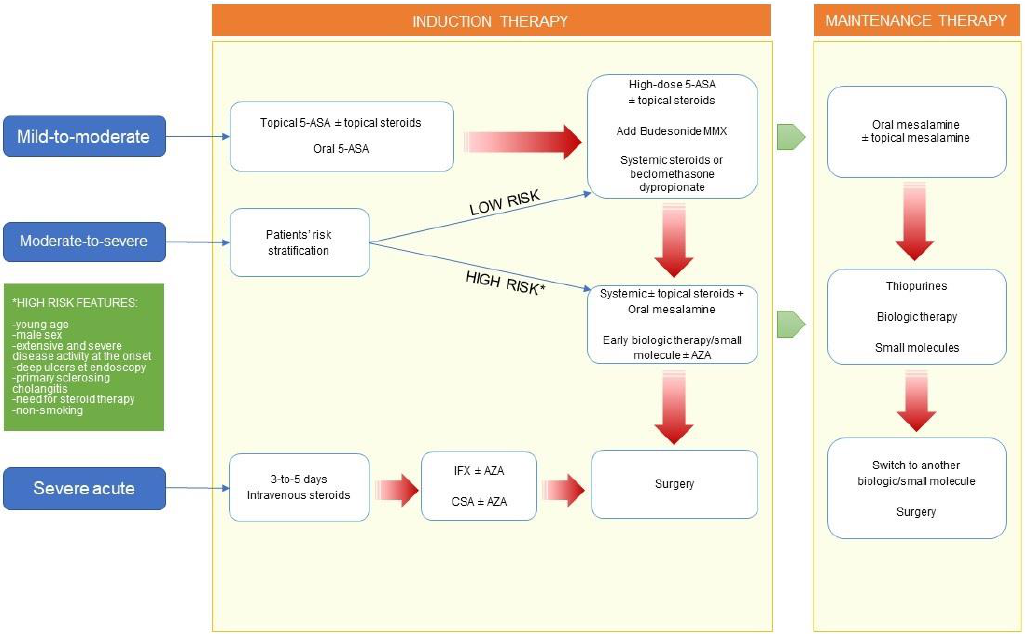
Figure 1. A suggested therapeutic algorithm for Ulcerative Colitis (UC) according to disease severity and patients’ risk stratification. Red arrows indicate non-responders. 5-ASA, mesalamine; MMX, multimatrix; AZA, azathioprine; IFX, infliximab; CSA,